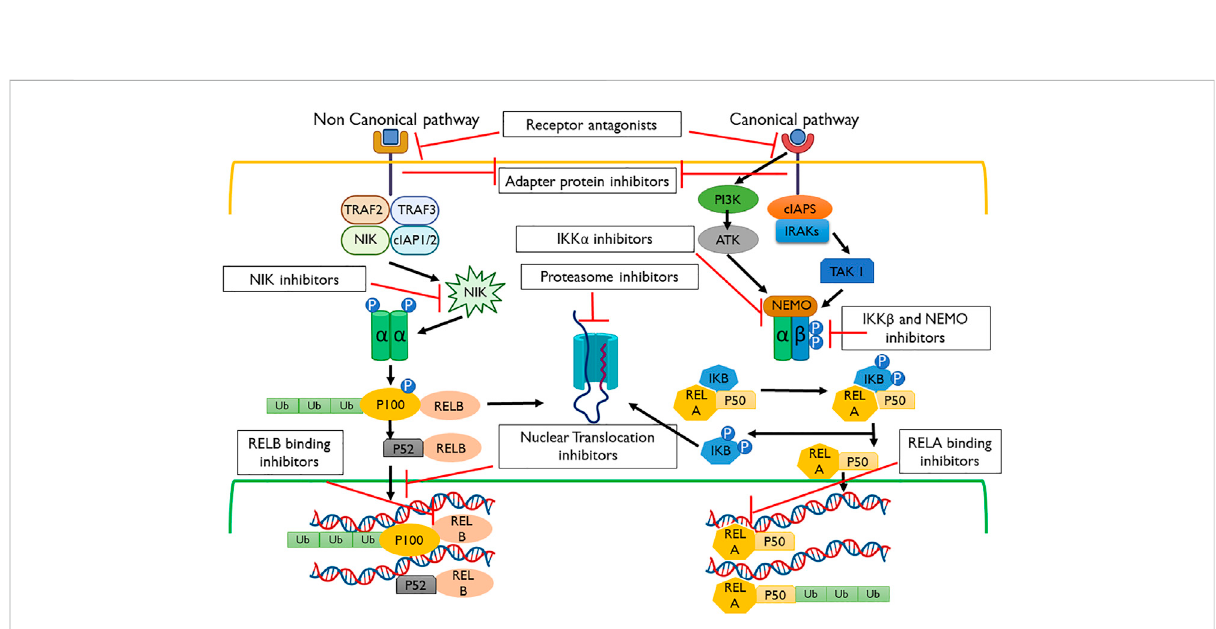
FIGURE 3 Pathways and inhibitors for NF- κ B activation. These signaling cascades are modulated within the non-canonical and canonical pathways using the receptor, adapter protein, IKK α , proteasome, NF- κ B-inducing kinase (NIK), nuclear translocation, REL-associated protein A (RELA), REL- associated protein B (RELB), and NF- κ B essential modulator (NEMO)